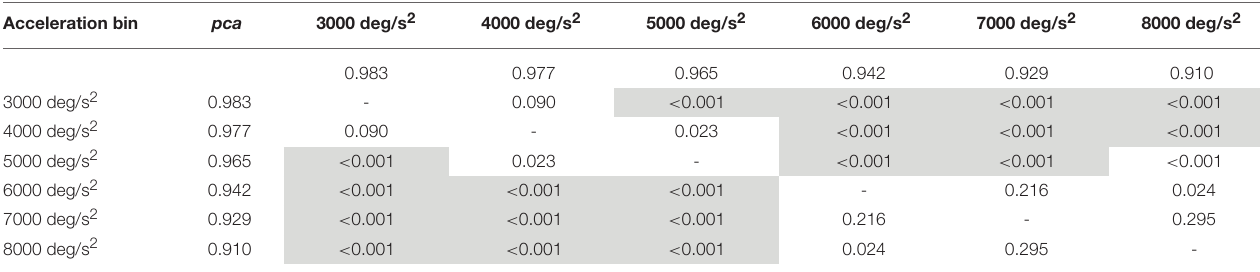
TABLE 3B | Whole athlete group : p -values of the multiple comparisons of pca between head acceleration bin—vertical canals. Acceleration